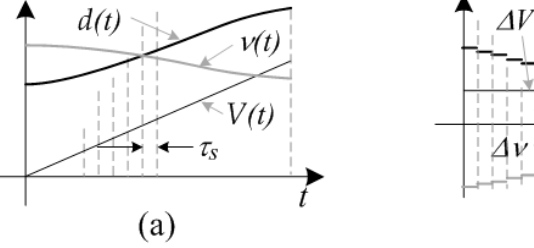
Figure 4. Operating principle of the proposed TLS: ( a ) linearly increasing PZT voltage ( V(t) ) result- ing in the non-linear change in the gap ( d(t) ) and the optical frequency ( ν (t) ) of TF, ( b ) the amount of change of each variable during τ s when the PZT-TF voltage increased linearly with time, and ( c ) V(t) showing the waveform that made Δ ν constant.